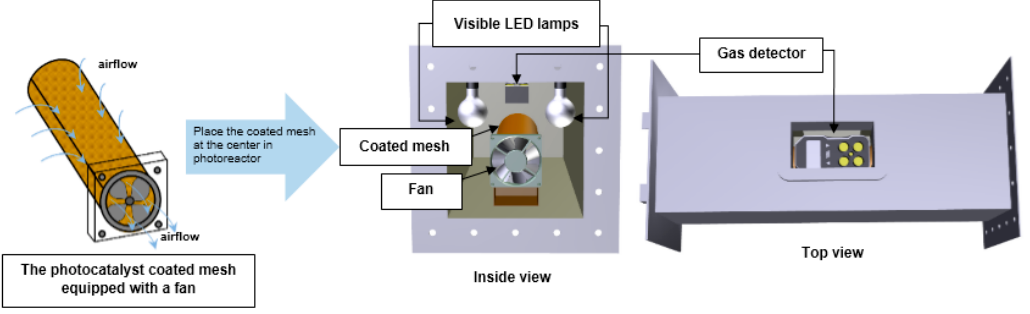
Figure 10. Schematic illustration of the cylinder of the photocatalyst coated mesh and a stainless steel photoreactor (inside and top views) with the two visible LED lamps and gas detector for a gas phase NH 3 decomposition test.